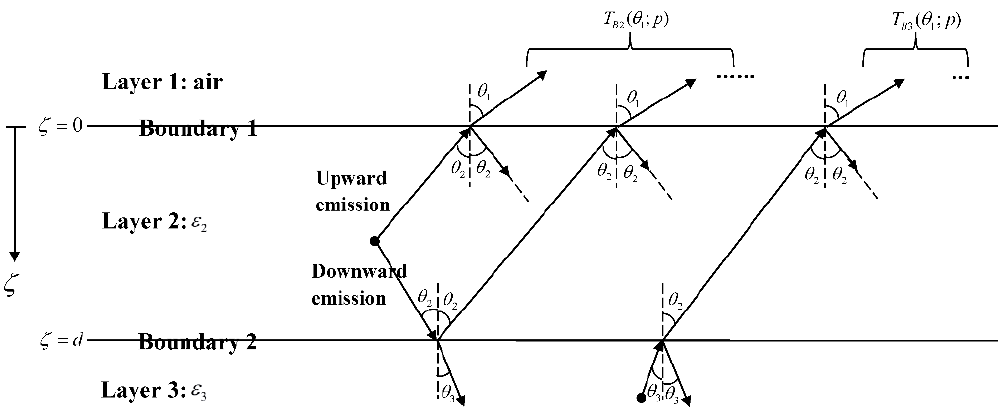
Figure 3. The emissions from layer 2 and layer 3 into layer 1 (air).